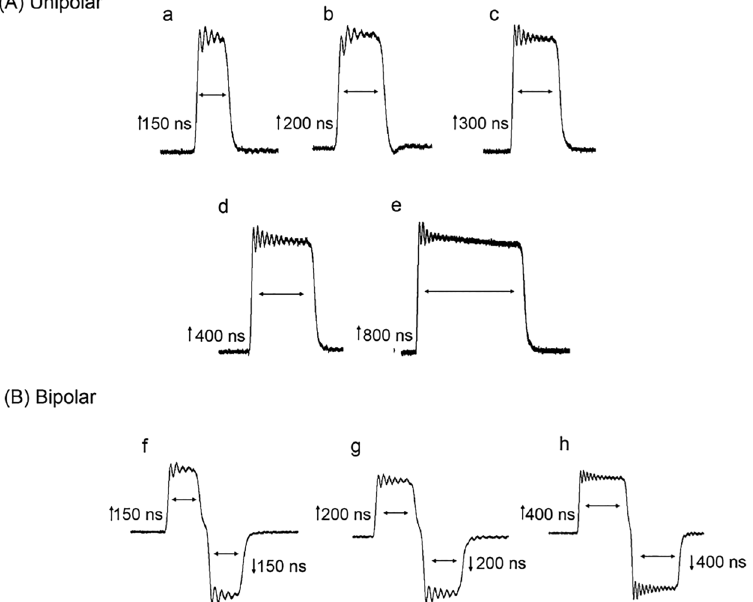
Figure 1. Oscilloscope traces of unipolar ( A ) and symmetrical bipolar ( B ) nsPEFs. (a–e) Unipolar nsPEFs were 150, 200, 400 and 800 ns in duration, all applied at an E-field of 3.1 kV/cm. (f–h) Symmetrical bipolar nsPEFs consisted of positive and negative phases of the pulse having the same duration, 150, 200 or 400 ns, and the same E-field of 3.1 kV/cm. Here and in all subsequent figures, the positive phase of the pulse was depicted by an upward arrow ( ↑ ) and the negative phase by a downward arrow ( ↓